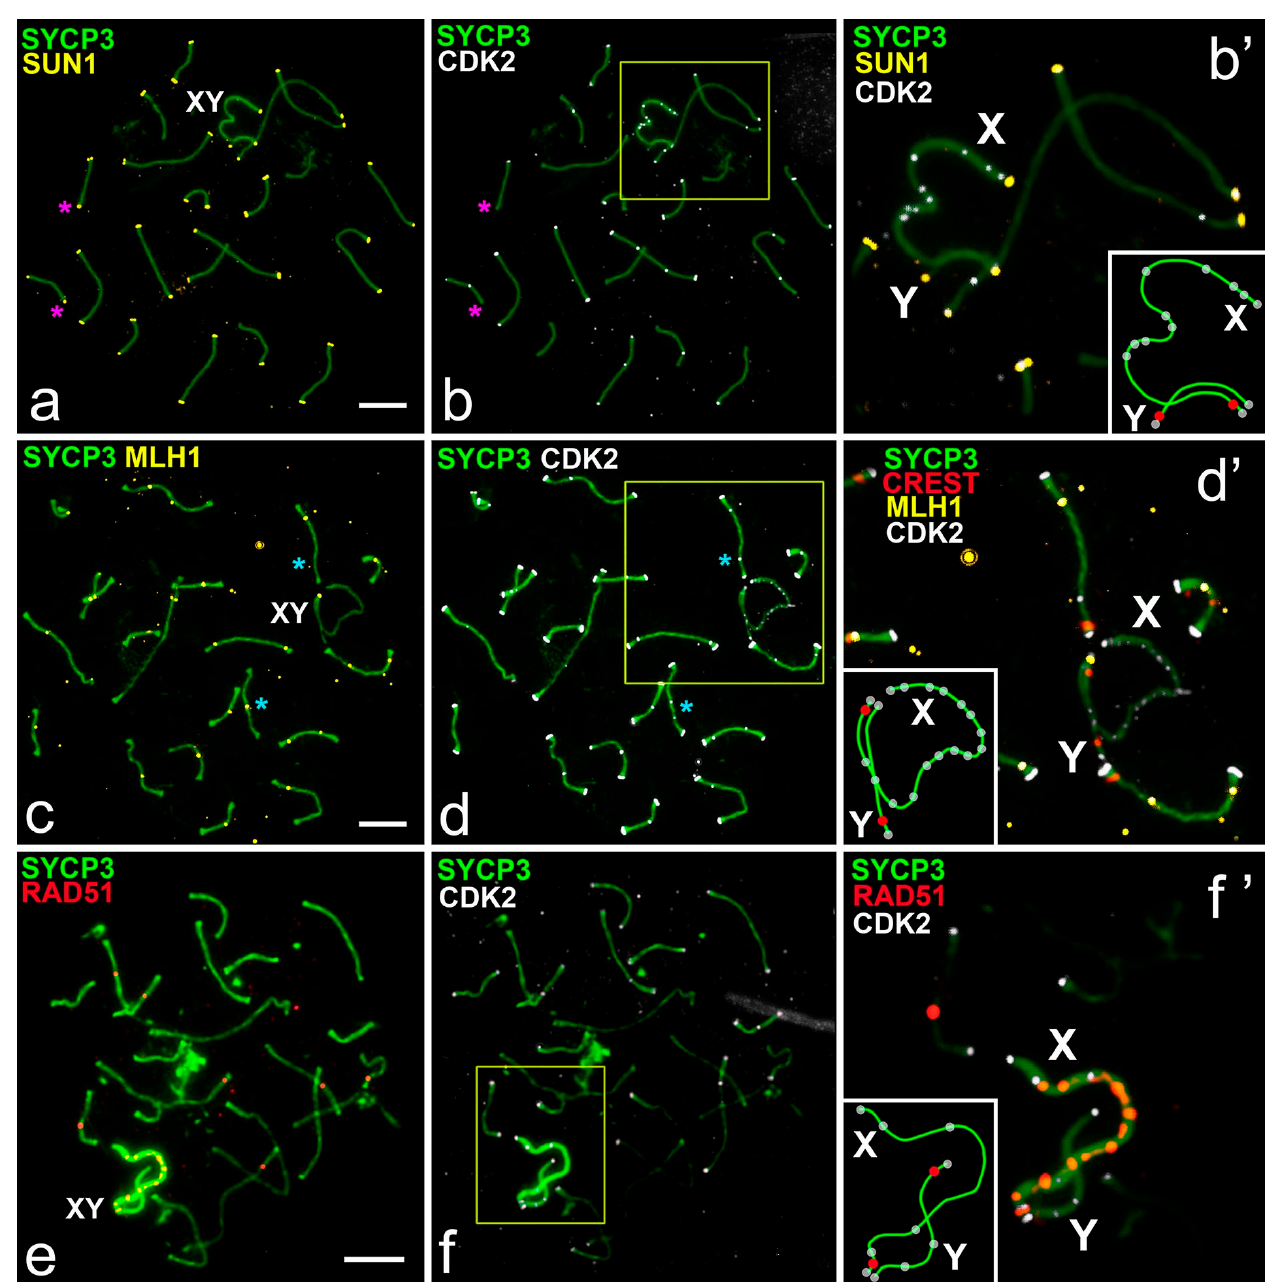
Figure 2. CDK2, SUN1, MLH1, and RAD51 distribution in the pachytene spermatocytes of the rat R. norvegicus . SCs were immunostained using antibodies to SYCP3 protein (green), and centromeres using antibodies to proteins of kinetochores (CREST, red). Schemes of sex chromosome synapsis, centromeric regions (red) and CDK2 foci (white) are shown in the insets ( b’ , d’ , f’ ). Pink stars pointed to non-colocalization of the SUN1 and CDK2 foci in some autosomal bivalents. Blue stars pointed to non-colocalization of the MLH1 and CDK2 foci in some autosomal bivalents. ( a , b ) CDK2 (white) and SUN1 (yellow) colocalized at the telomeric sites of SC. CDK2 signals were detected in asynapsed parts of the X chromosome ( b’ ). ( c , d ) Colocalization of the CDK2 (white) and MLH1 (yellow) at the interstitial sites of autosomal SCs. The X chromosome showed numerous CDK2 foci, whereas the Y showed single CDK2 foci. Both sex chromosomes had CDK2 foci in the telomeric parts ( d’ ). ( e , f ) CDK2 (white) and RAD51 (red) signals did not colocalize and had different positions in chromosomes. There were numerous RAD51 foci on the X chromosome, whereas the Y lacks these signals. Rare signals of CDK2 were detected on the Y chromosome ( f’ ). Scale bar ( a – f ) = 5 µ